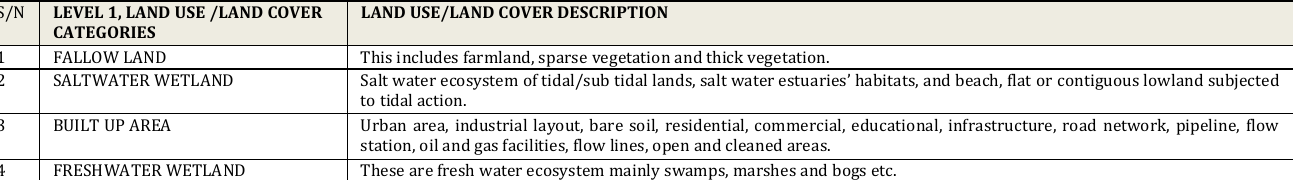
Table 2: Land Use/Land Cover Classification